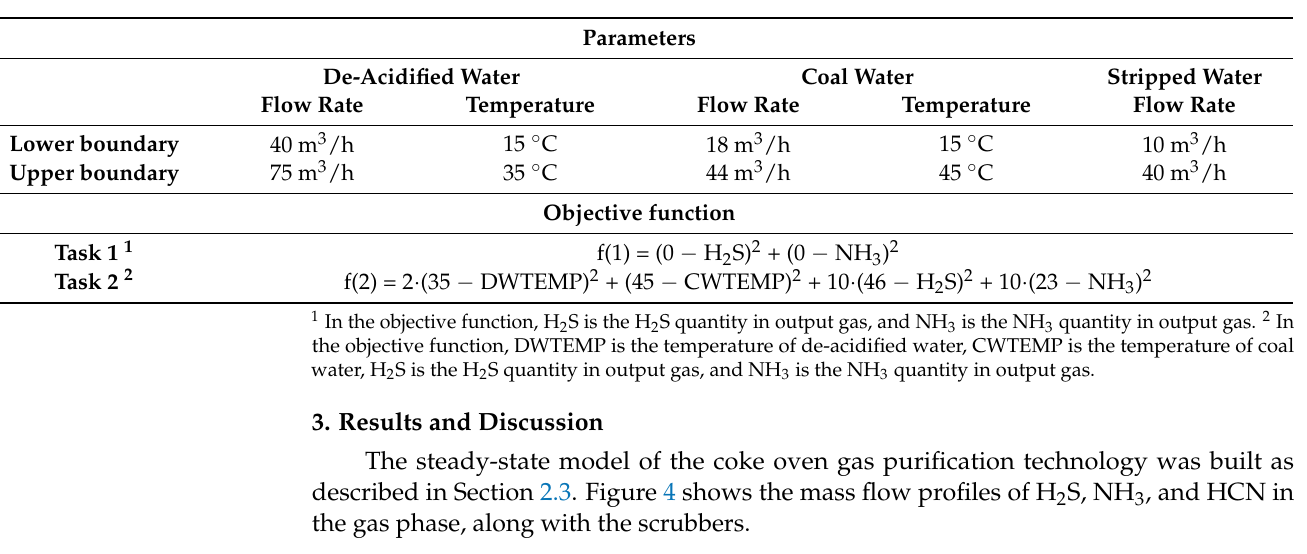
Table 4. Parameters and objective functions of optimisation tasks.